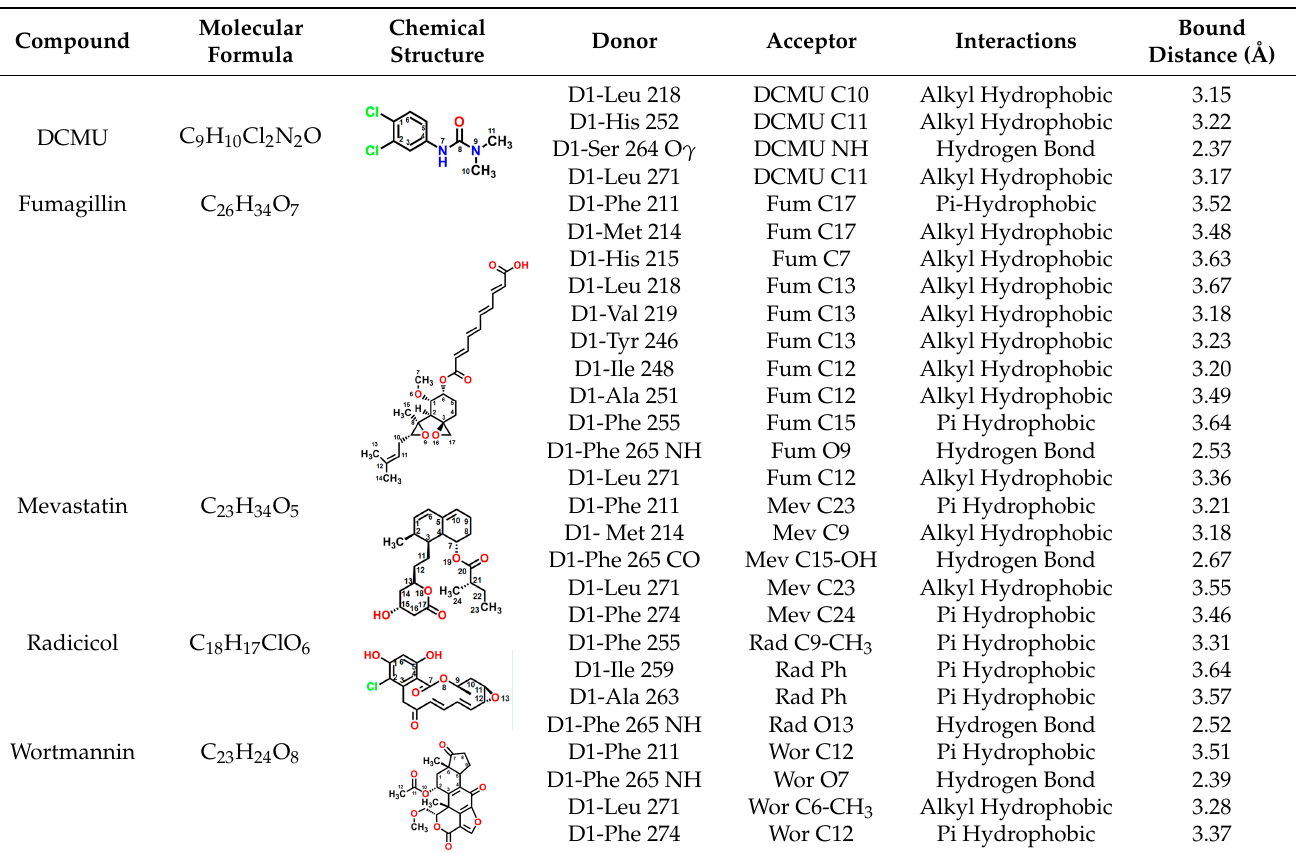
Figure 7. Docked poses of fumagillin ( A ), mevastatin ( B ), radicicol ( C ), wortmannin ( D ), and DCMU ( E ) inside the Q B binding site of D1 protein of C. reinhardtii (6KAC). The surface representations of the four mycotoxins bound to the Q B site showed their positions in the binding pocket (Figure 7). The short alkyl side chain of fumagillin entered inside the cavity, and its long unsaturated carboxyl side chain and cyclohexane ring were partly exposed outside the cavity (Figure 7A). The six-membered oxygen-containing het- ero ring of mevastatin entered the Q B binding pocket; other parts lay along the wall of the cavity (Figure 7B). For radicicol, the fifteen-membered hetero ring entered the Q B binding pocket, except for the benzene ring (Figure 7C). The results of the docking model sug- gested that the four mycotoxins show binding affinity for binding the Q B site. However, DCMU totally enters the cavity formed by the Q B binding pocket (Figure 7E). This may be the reason why the inhibitory activity of the four mycotoxins against PSII was weaker than that of DCMU. Table 1. Possible binding interactions for DCMU, fumagillin (Fum), mevastatin (Mev), radicicol (Rad), and wortmannin (Wor) to the D1 protein of C. reinhardtii. Compound Molecular Formula Chemical